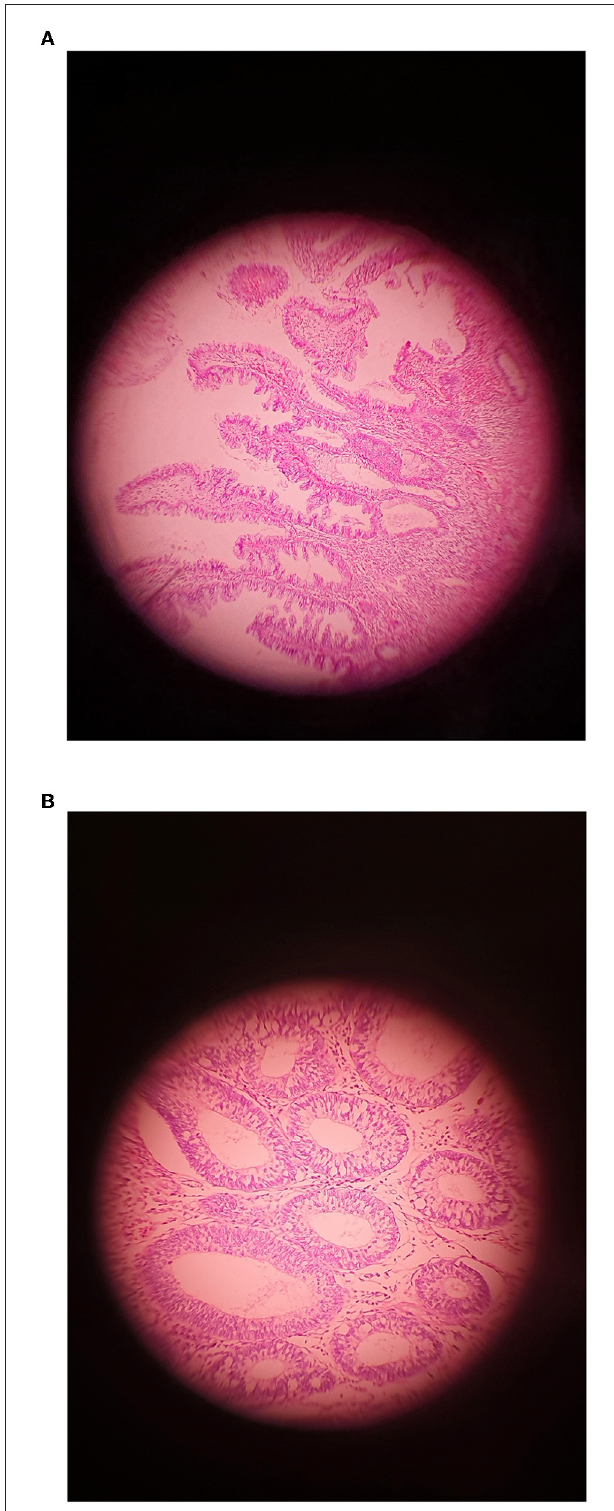
FIGURE 1 | An example of Adenoma showing (A) LGD and (B) HGD (Original magnification × 400).